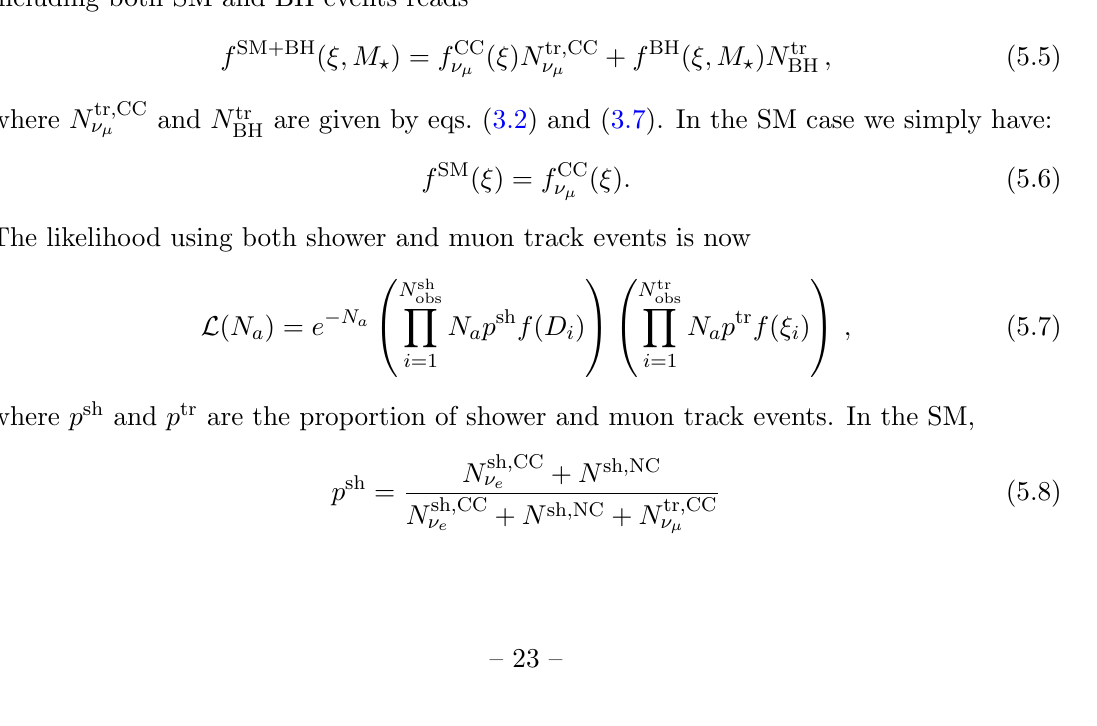
JHEP04(2020)187